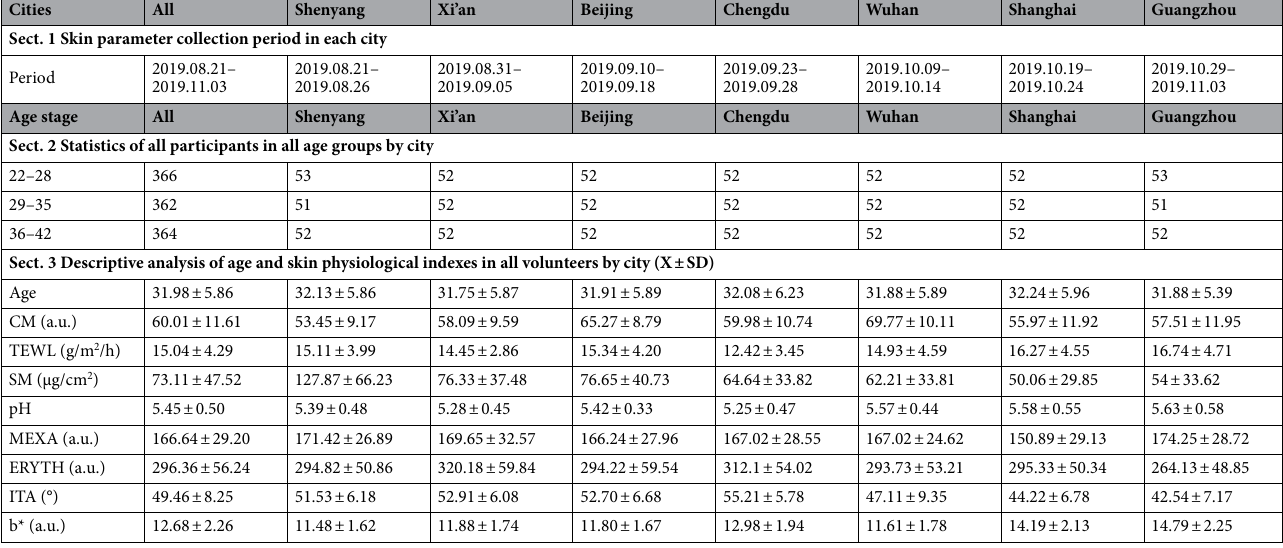
Table 2. Overall statistics of all